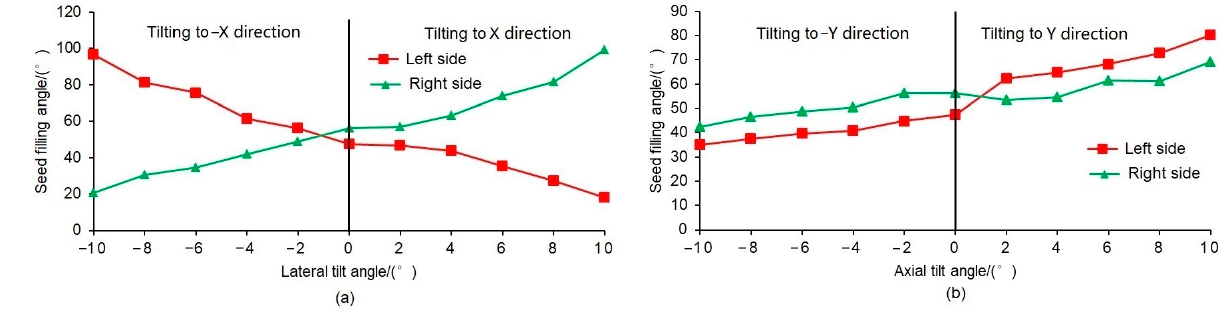
Figure 9. Effects of inclination angle on seed-filling angle: ( a ) lateral inclination angle and ( b ) axial inclination angle.